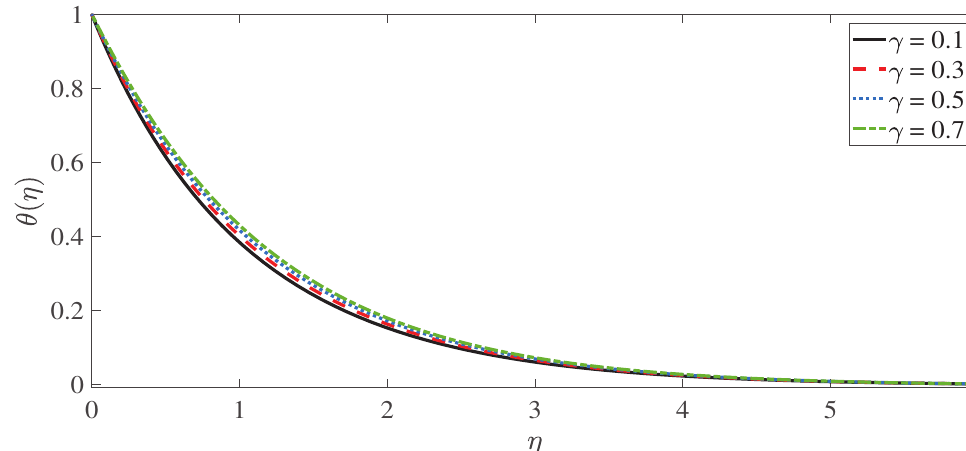
Figure 6. Temperature profile for permeability parameter γ .